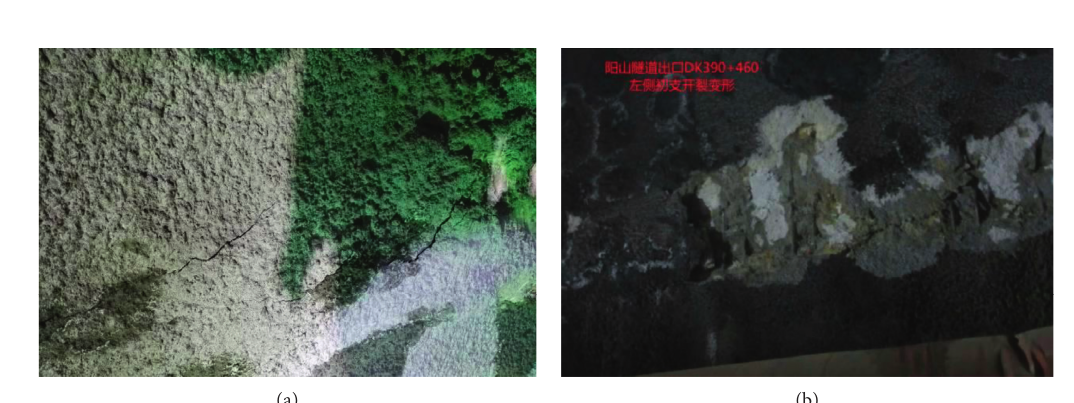
Figure 17: Primary support cracking and spalling (scheme II).